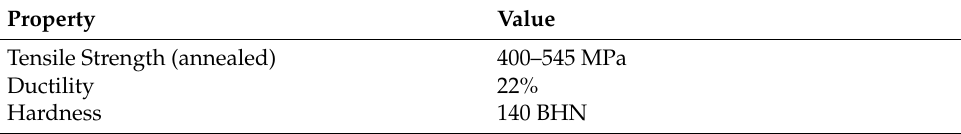
Table A2. Mechanical Properties of Hot rolled Low Carbon Steel (AISI A36).